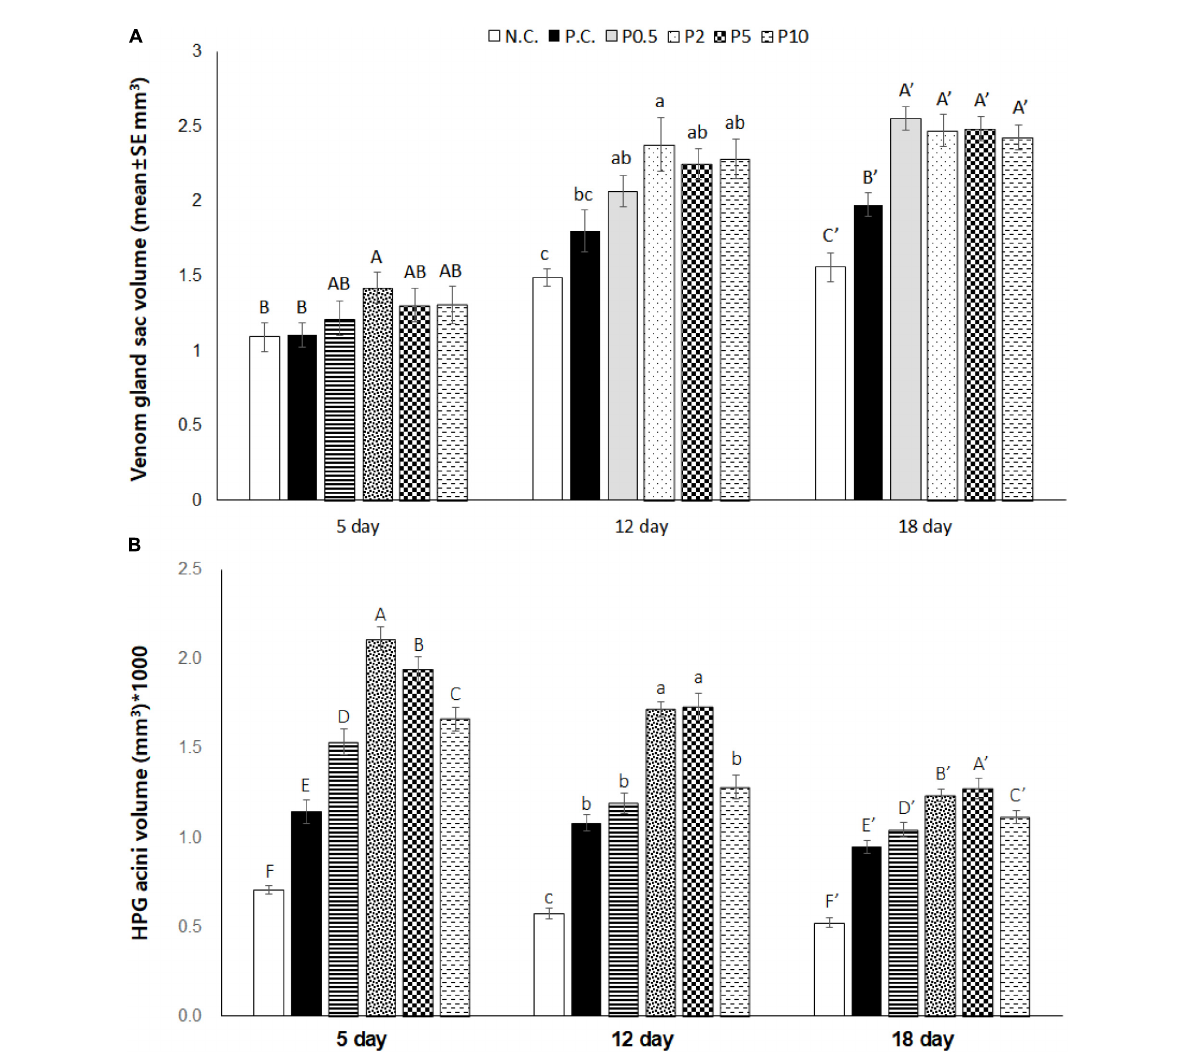
FIGURE5 (A) Venom gland sac volume (mean ± SE mm3) and (B) hypopharyngeal gland acini volume (mean ± SE mm3 ∗ 1,000) measured on days 5, 12, and 18 in caged honey bees fed with different diets. NC means negative control; PC means positive control. Different letters over the bar indicate statistically significant differences ( p <